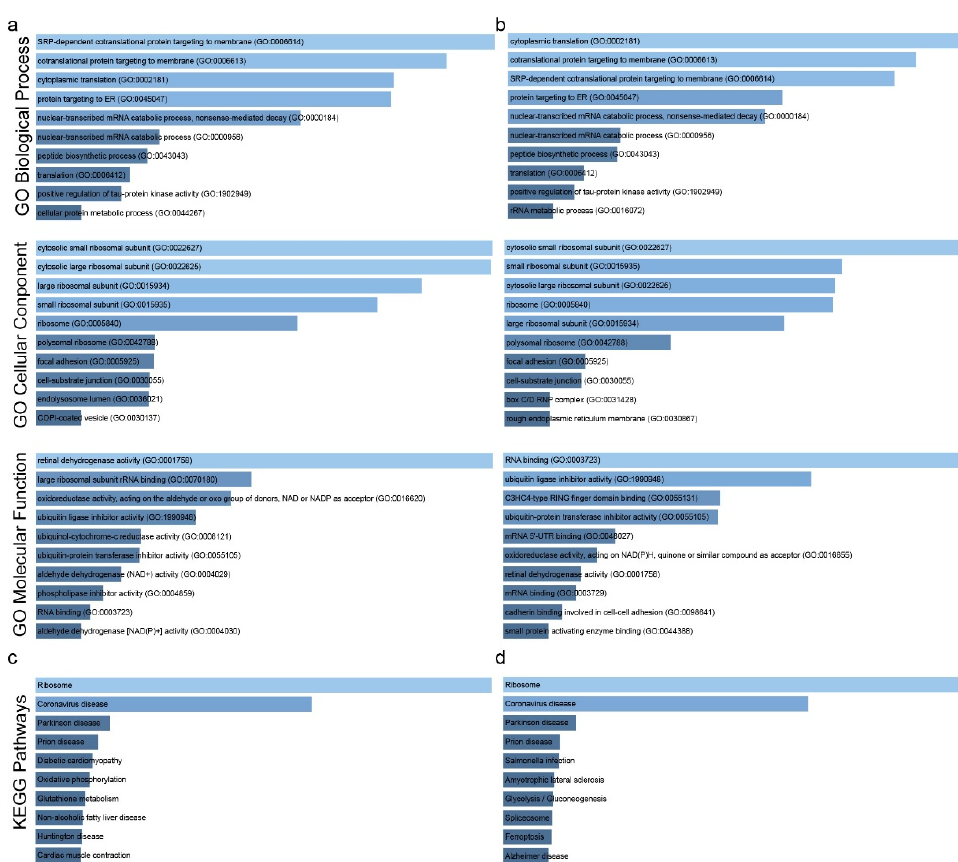
Figure 7. GO enrichment of the co-upregulated ( a ) and the co-downregulated ( b ) genes in drug perturbation experiments in lung cancer. KEGG enrichment for the co-upregulated ( c ) and the co-downregulated ( d ) genes in single-gene perturbation experiments in lung cancer. Bar graphs were sorted using a combined score between the Benjamini–Hochberg (BH)-adjusted p -value and the z-score of the deviation from the expected rank. Each bar’s length shows the significance of the corresponding term relative to the color brightness of each